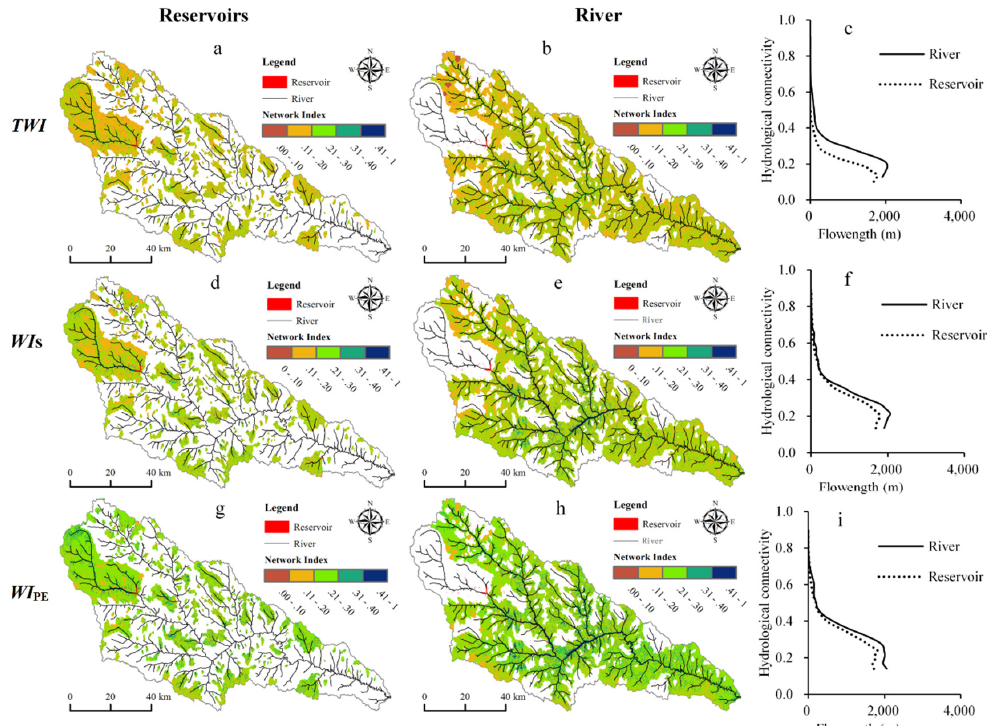
Figure 7. Spatial pattern of HC_TWI ( a ), HC_WI S ( d ), and HC_WI PE ( g) in the effective catchment area ( ECA ) of reservoirs; the spatial pattern of HC_TWI ( b ), HC_WI S ( e ), and HC_WI PE ( h ) in the ECA of the river network; and relationships between hydrological connectivity and flow length (c, f, i).